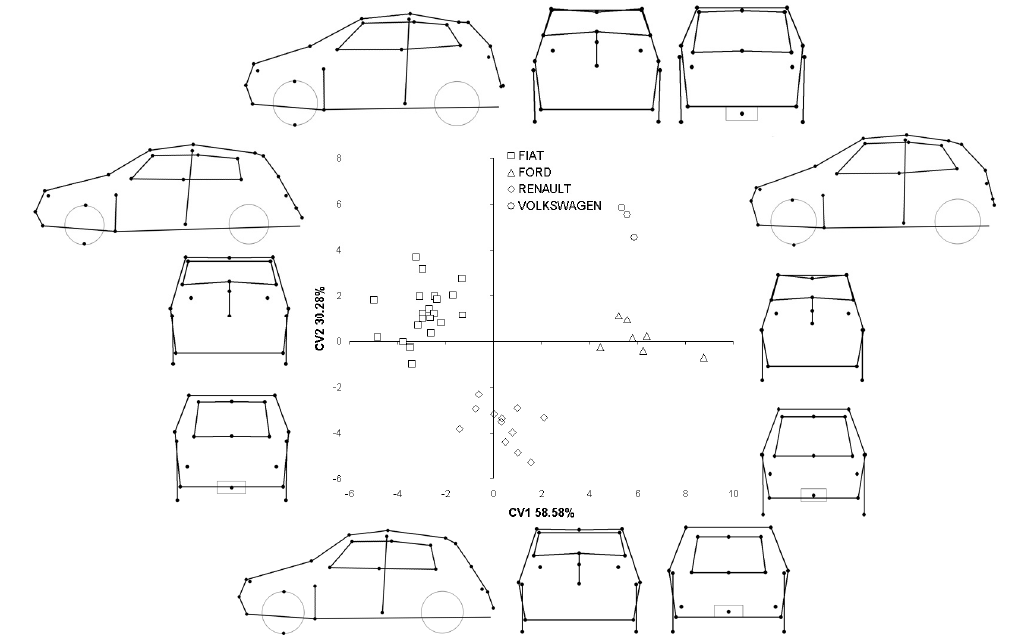
Figure 4. Canonical Variate Analysis (CVA) output for the four brands. All around the central plot, it is possible to observe the splines (lateral, front, and back views) relative to the extremes of the two CV axes ( CV1 left and right; CV2 up and